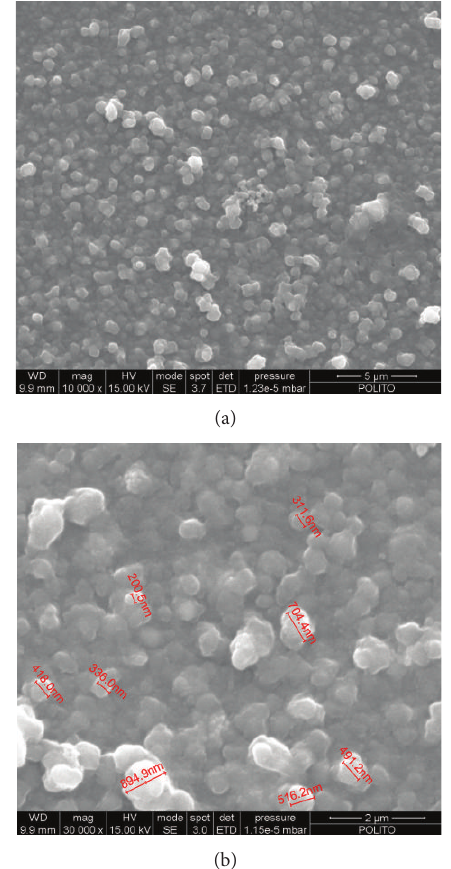
Figure 10: SEM pictures showing the high homogeneity and microporosity of V 2 O 5 film electrodeposited on